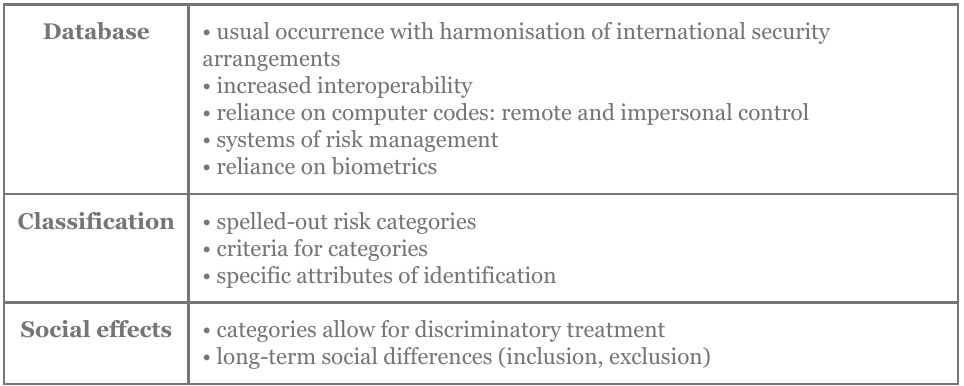
Table 1 - Operationalisation: characteristics of social sorting (cf. Ball et al., 2012; Lyon,